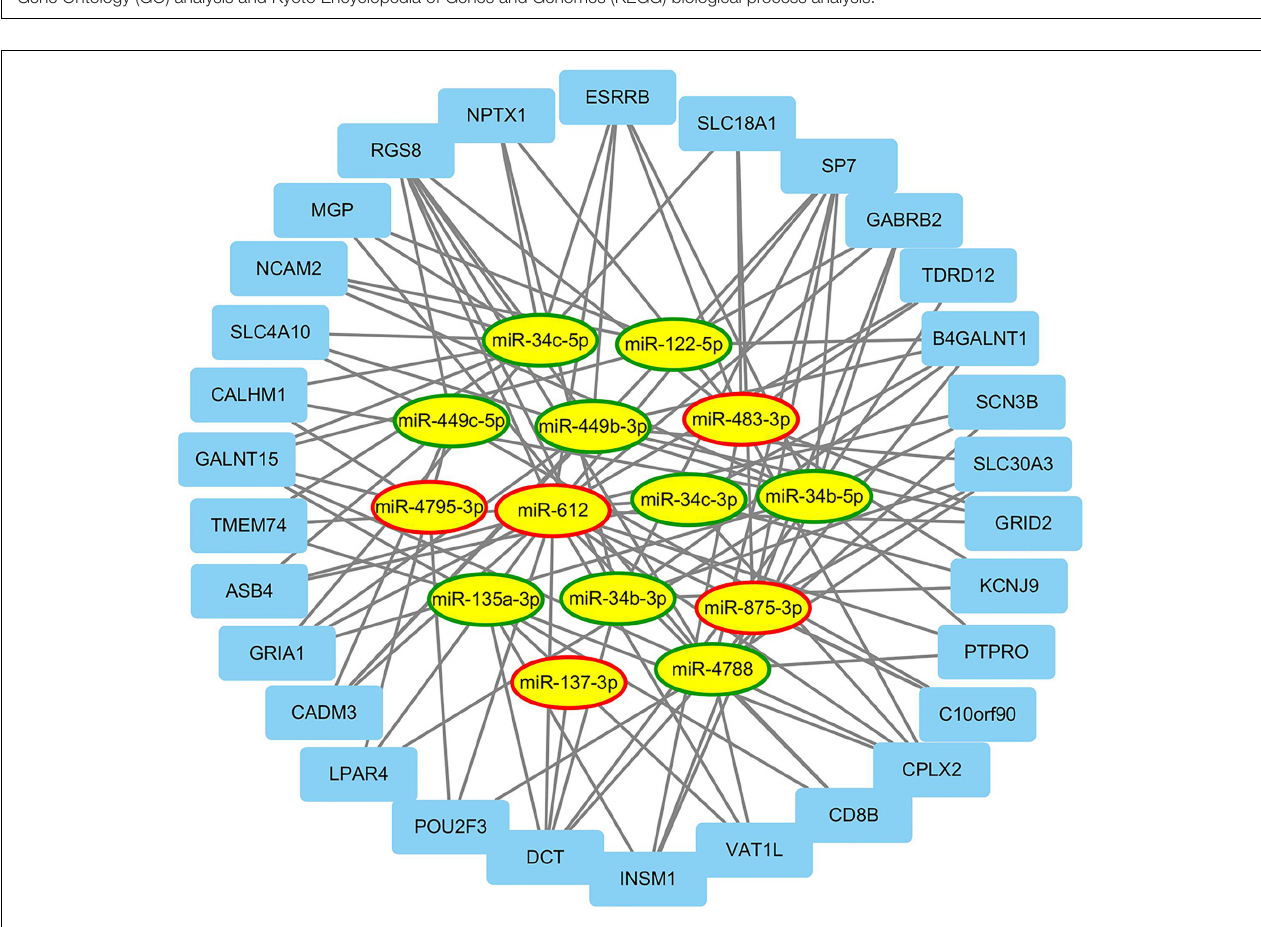
FIGURE 5 | The regulatory network between miRNAs and differentially expressed mRNAs. This figure describes the regulatory network between miRNAs and differentially expressed mRNAs associated with lymph node metastasis (LNM) in endometrial endometrioid carcinoma (EEC). The ellipses and rectangles represented the miRNAs and mRNAs, respectively. The red and green rings indicated relatively upregulated and downregulated expression in EEC patients with LNM, respectively.